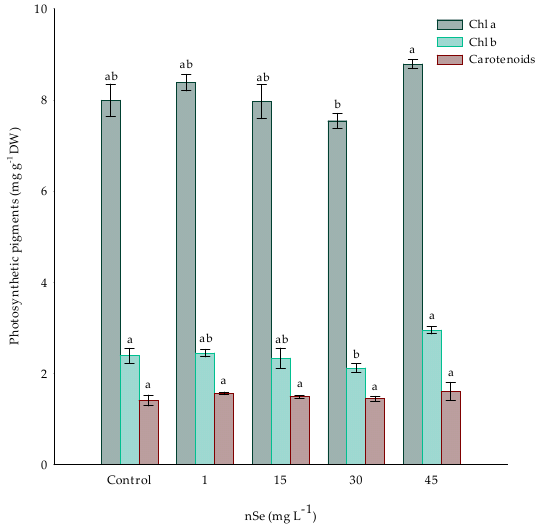
Figure 3. Photosynthetic pigments in Jalapeño pepper plants with nSe in a drench. Different letters indicate differences between treatments (Tukey test p ≤ 0.05). Chl a: chlorophyll a; Chl b: chlorophyll b; DW: dry weight. n = 3 ± standard error.